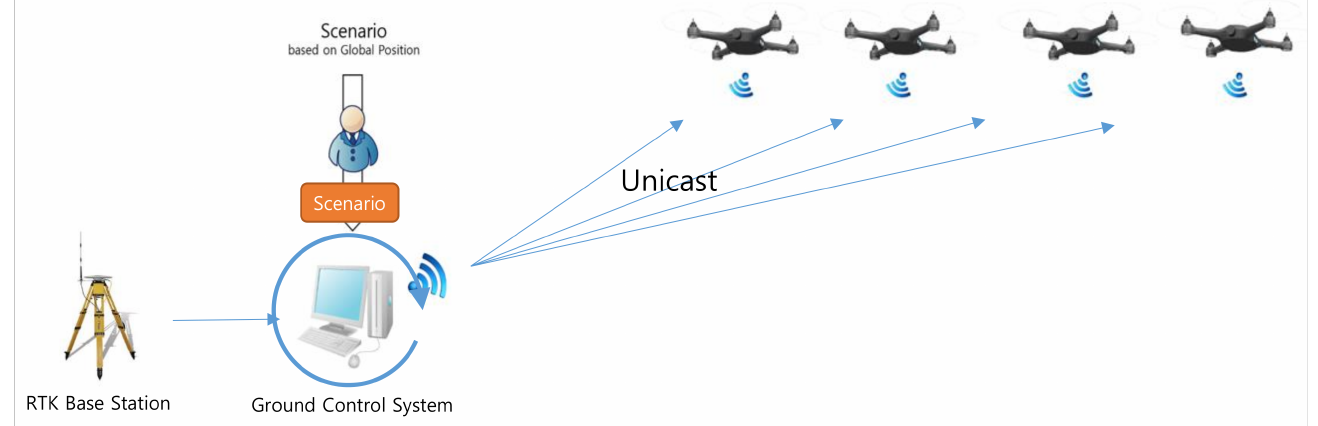
Figure 4. Traditional communication approach for the swarming flight.